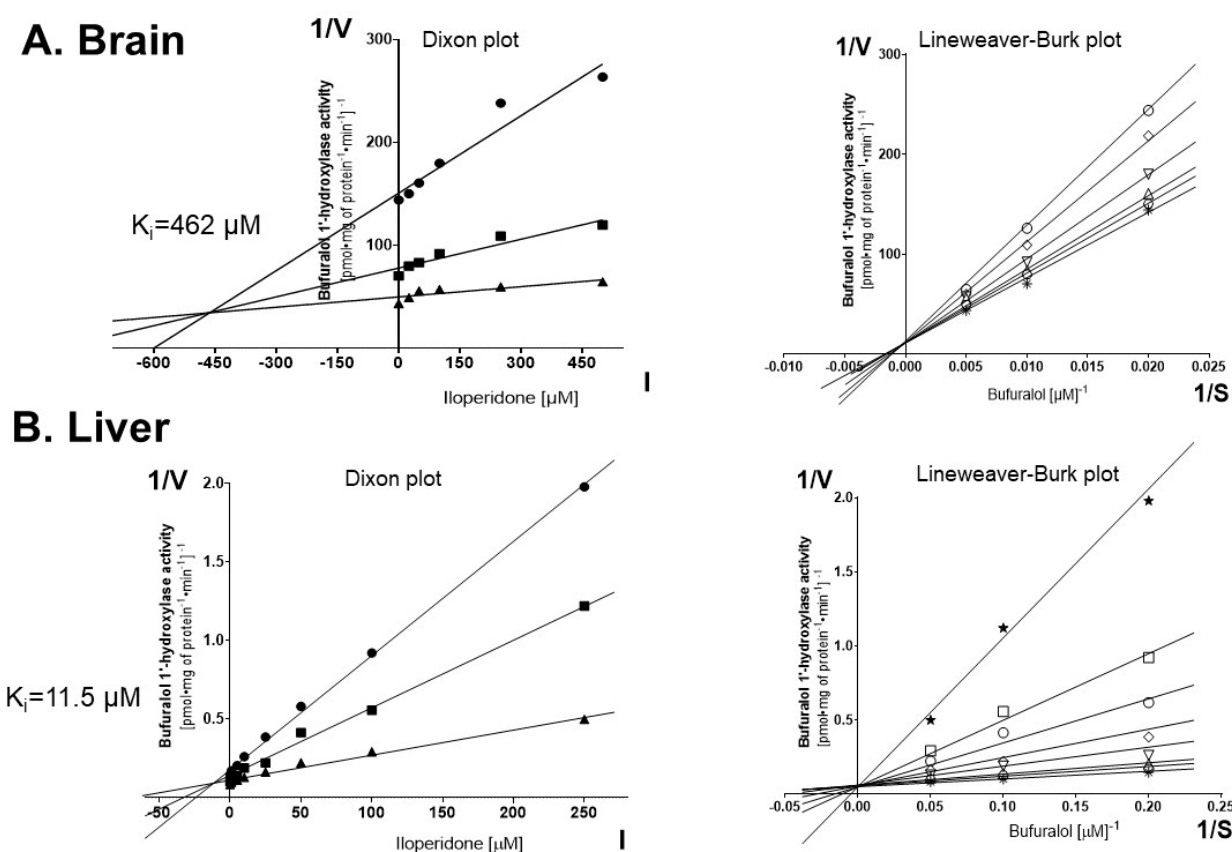
Figure 1. The effects of iloperidone added in vitro to pooled brain or liver microsomes ( n = 10) on the activity of CYP2D determined as the rate of bufuralol 1 ′ -hydroxylation. Each point shows the mean value of two independent analyses. ( A ) Brain. Kinetic parameters: K m = 492.1 μ M, V max = 0.076 pmol ∙ mg protein − 1 ∙ min − 1 , K i = 462 μ M. Dixon plot: bufuralol con- centrations of 50 μ M ( ● ), 100 μ M ( ■ ) and 200 μ M ( ▲ ). Lineweaver-Burk plot: control—no asenapine ( ✱ ); the asenapine